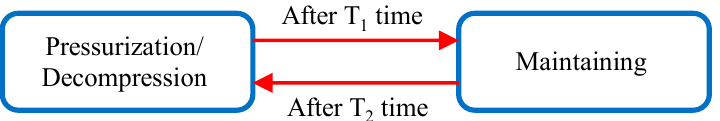
Figure 7. Schematic diagram of the SPWM control method.